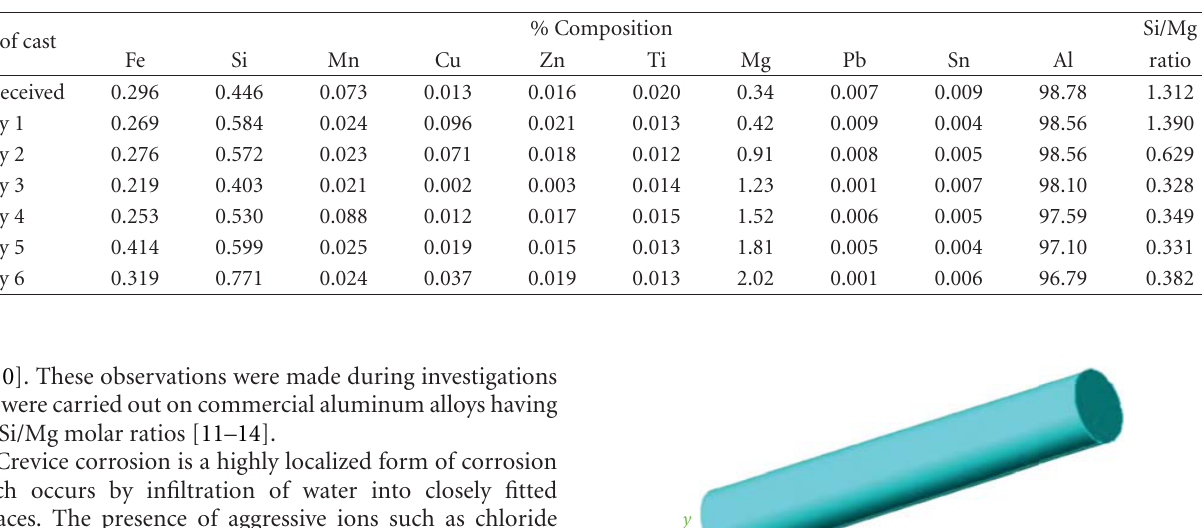
Table 1: Al-Mg alloy chemical composition.